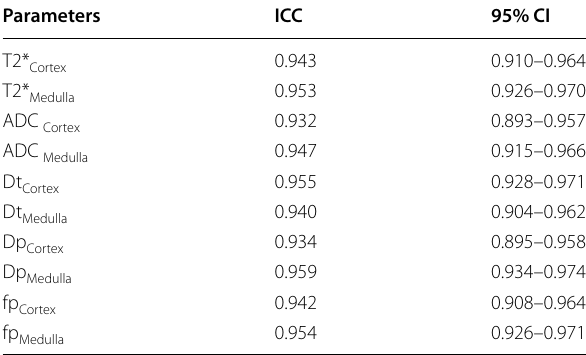
Table 3 The interobserver agreement for different MRI parameters between two radiologists